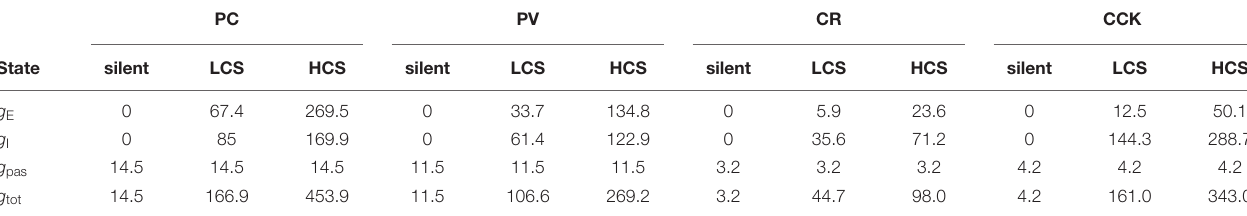
TABLE 2 | Components of conductance at different activity levels for the examined neuron types. PC PV CR